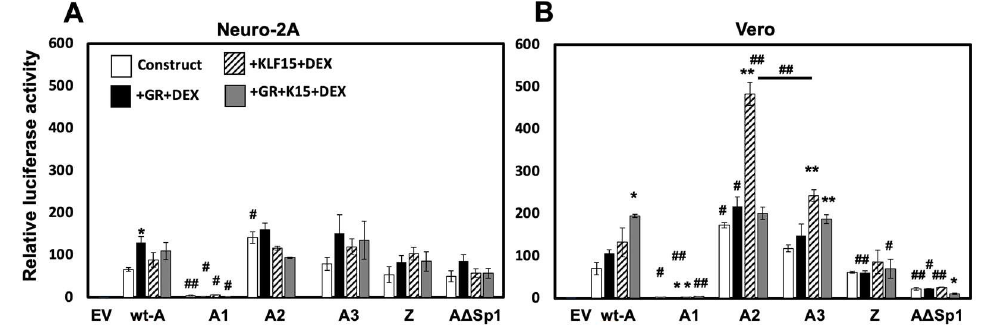
Figure 3. Identification of sequences in ICP0 fragment A that mediate transactivation by GR, KLF15, and/or DEX. Neuro-2A ( Panel A ) or Vero ( Panel B ) cells were transfected with 0.5 µg of the wt A luciferase construct, or the designated A mutant fragments and Renilla luciferase expression plasmid (0.05 µg), as described in Materials and Methods. Where indicated, the denoted cultures were co-transfected with GR (1 ug) and/or KLF15 (0.5 ug) expression plasmids. Empty vector (pGL4.24[luc2P/minP]) was added to cultures to maintain the same DNA amount. 24 h after transfection, certain cultures were treated with DEX (10 uM). Cells were harvested at 48 h, and dual luciferase assay was performed. Luciferase activity was calculated relative to empty vector (EV) luciferase value. Results are the mean of three experiments, and error bars denote the standard error. An * denotes a significant difference compared to the luciferase construct alone. A # denotes a significant difference in the denoted mutant construct relative to the respective wt A transfected samples. A */# denotes a significant difference of p < 0.05, whereas a **/## denotes a significant difference of p < 0.005, as determined by Student’s t -test.